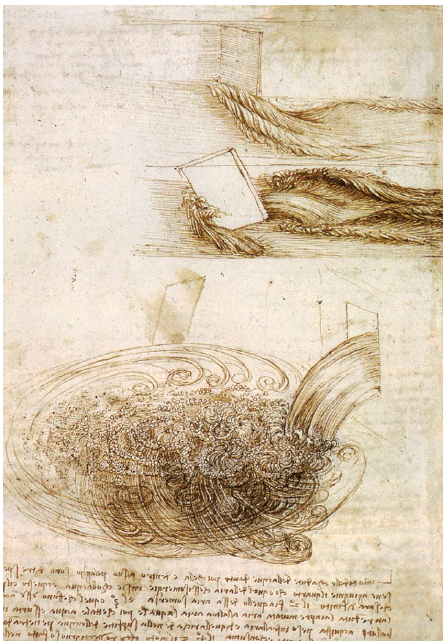
Figure 2. A free water jet issuing from a square hole into a pool.